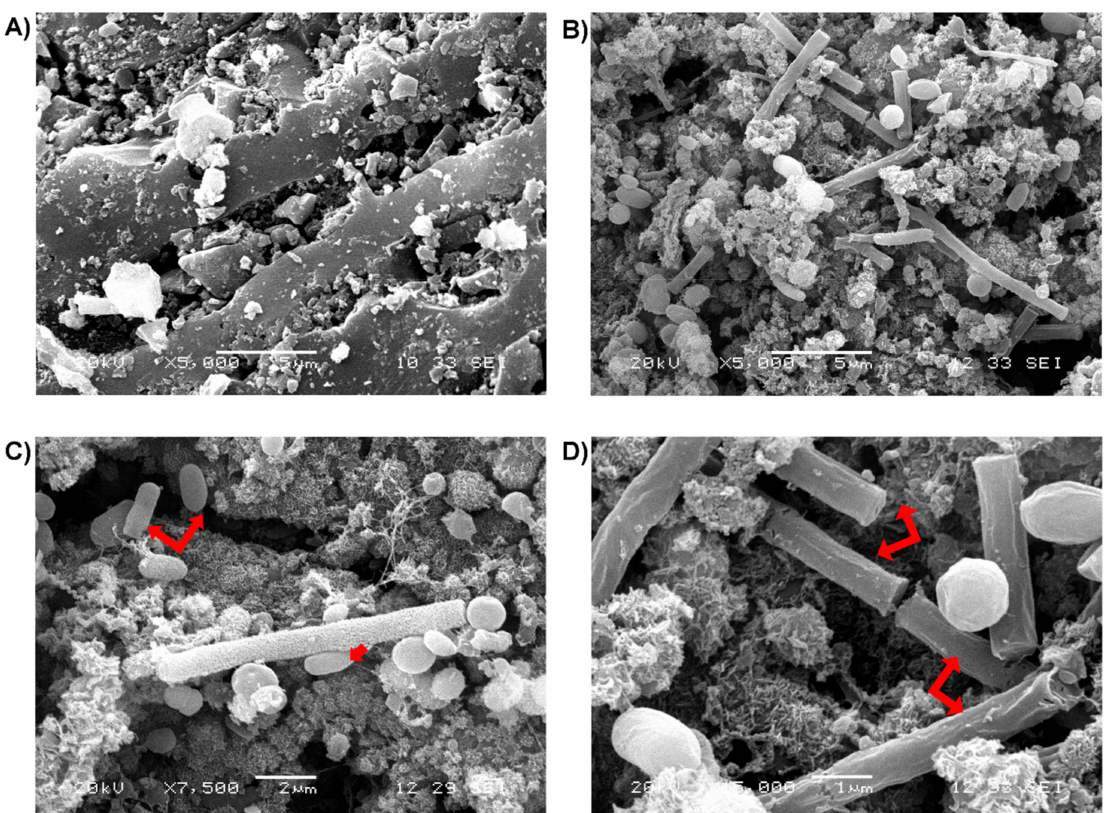
Figure 5. Scanning electron micrographs of the granular activated carbon surface ( A ), biofilm attached granular activated carbon ( B ), Geobacter communities attached to granular activated carbon ( C ), and Methanosaeta communities attached to granular activated carbon ( D ) after biochemical methane potential test (30